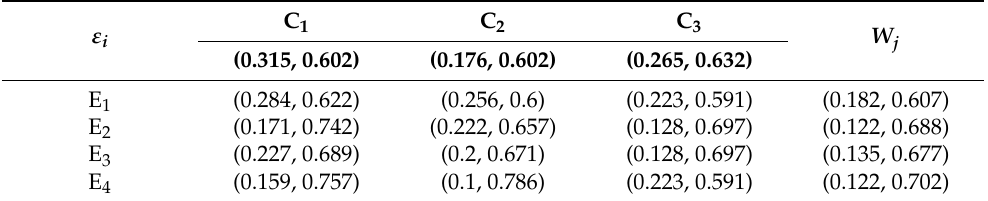
Table 13 shows the aggregated intuitionistic fuzzy priority of C i . Table 13. The aggregated intuitionistic fuzzy priority of C i .